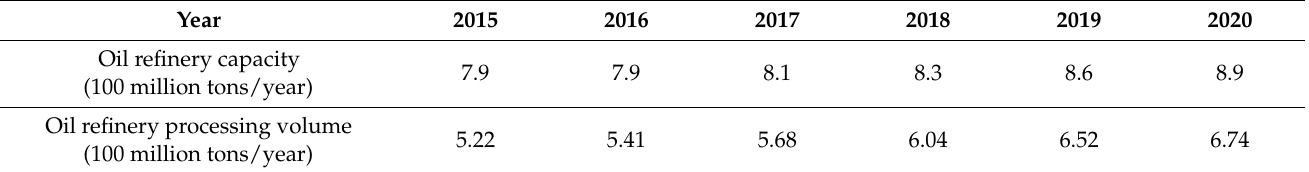
Table 2. The capacity and processing volume of the domestic PR industry from 2015 to 2020